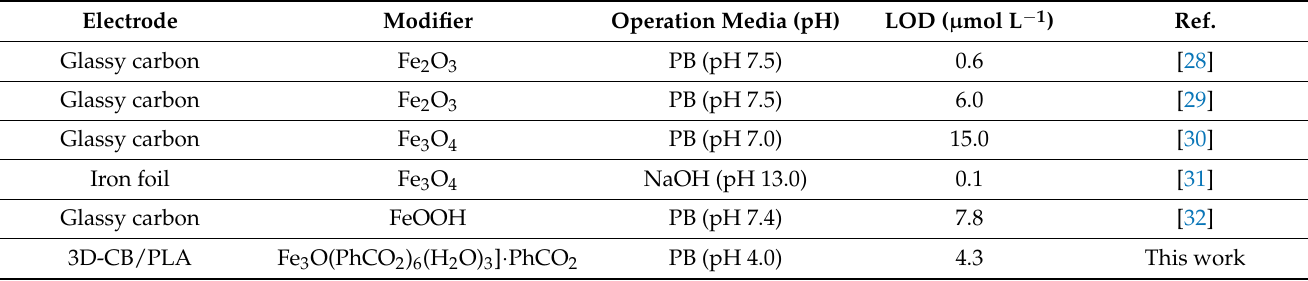
Table 1. Performance comparison of various iron-based nonenzymatic glucose